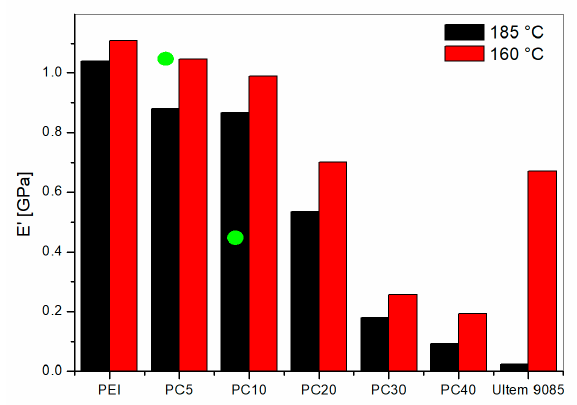
Figure 9. Storage Modulus values calculated at 165 °C and 185 °C from graph of E ′ versus temperature. Green circles represent the value for PEI/PETG blends.